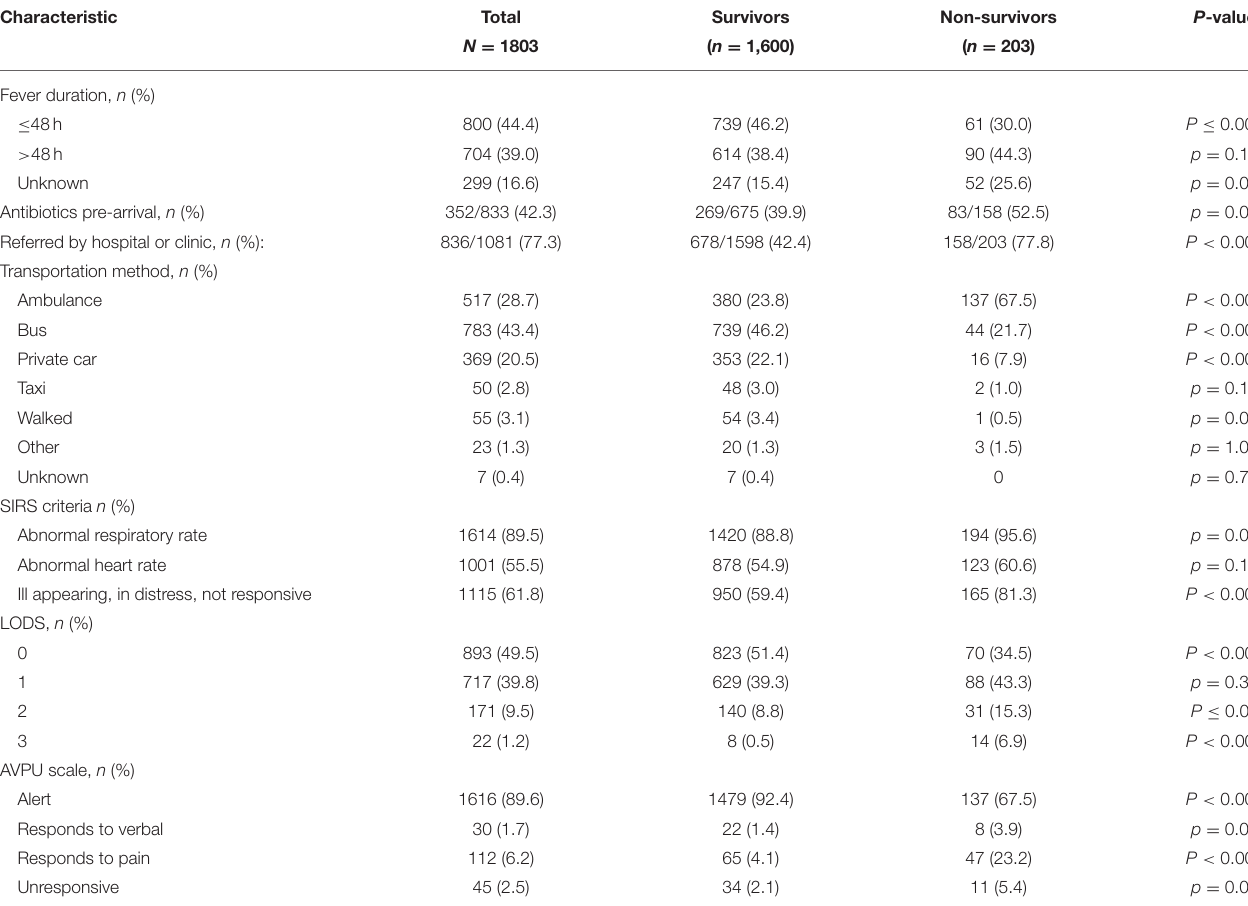
TABLE 3 | Descriptive statistics for the full cohort and a comparison of pre-arrival characteristics and illness severity measures by mortality outcome.